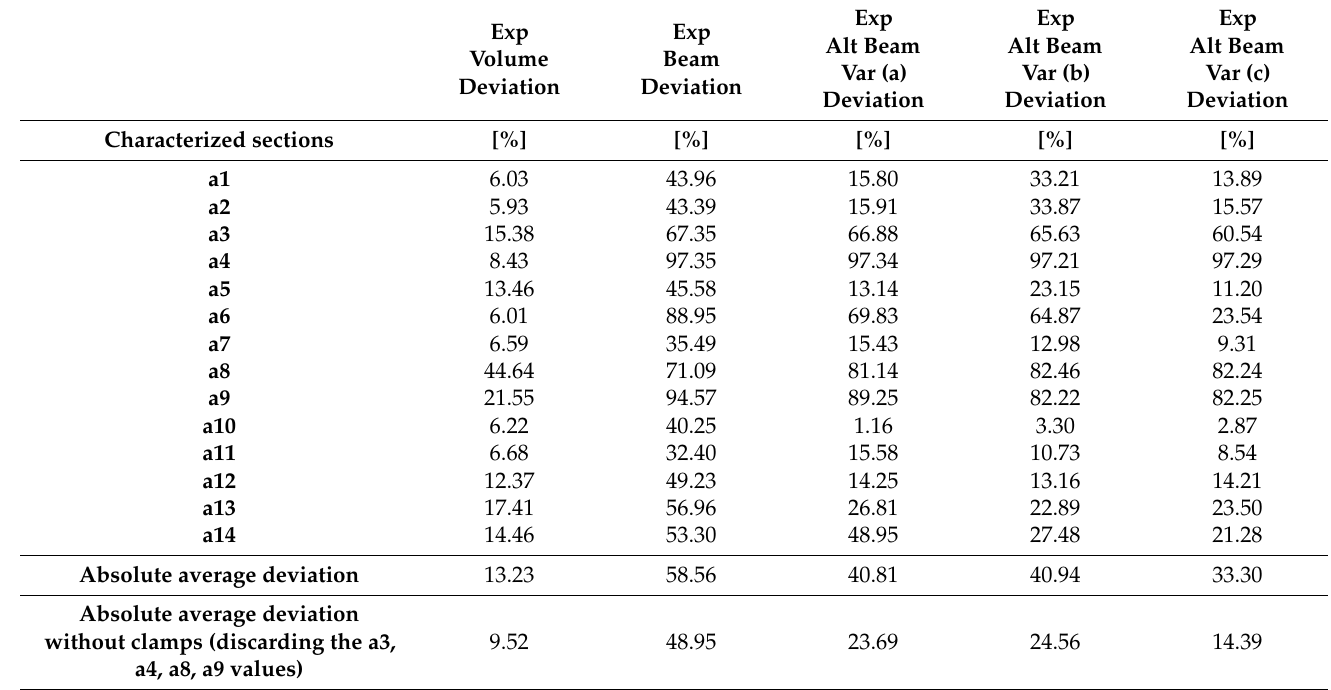
Table 1. Deflection relative differences of the FEM models with respect to the experimental